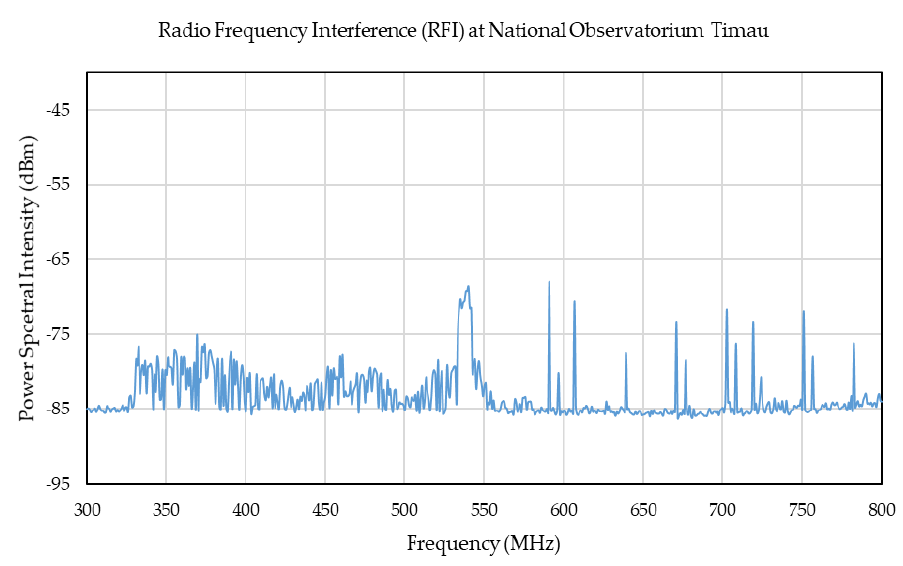
Figure 5. Results of radio frequency survey at low frequencies between 300 and 800 MHz.